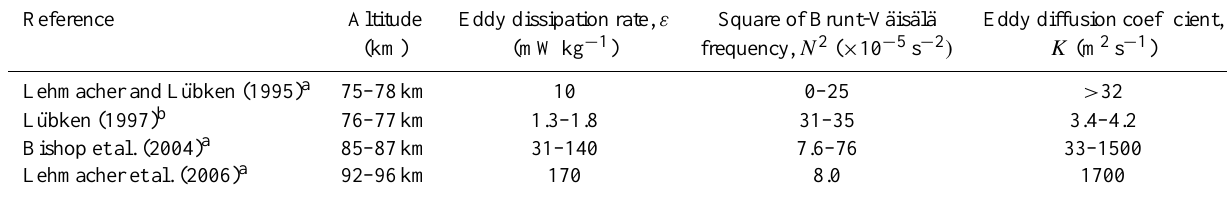
Table 3. Measured eddy dissipation rates and diffusion coefficients in the upper mesosphere and lower thermosphere. Reference